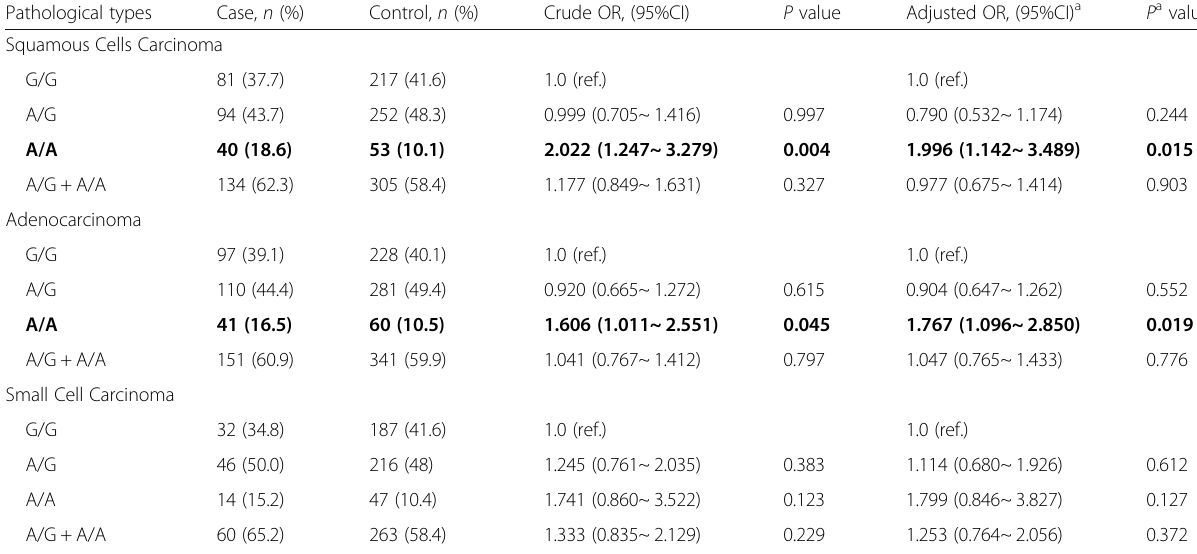
Table 4 Stratification analyses of H19 polymorphisms (rs217727) and risk of LC Pathological